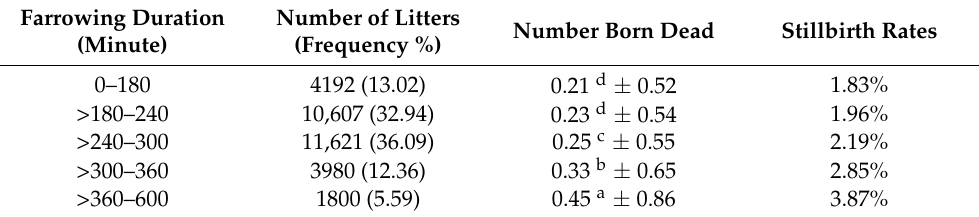
Table 4. Descriptive statistics of number born dead piglets of different farrowing